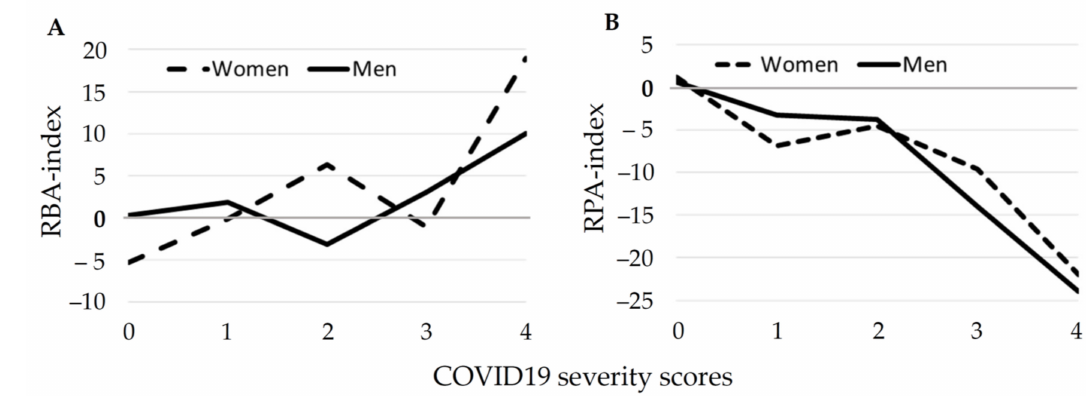
Figure 3. Dynamics of the RBA, relative biological aging index ( A ) and RPA, relative psychological aging index ( B ) in comparison with the severity of the disease in men (solid line) and women (broken line), both from working group. For an explanation of COVID-19 severity scores, see Materials and Methods